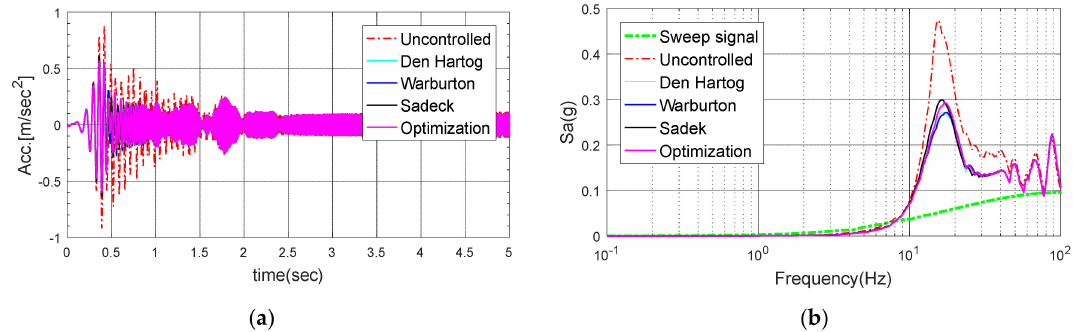
Figure 20. Acceleration response at the top of the electrical cabinet when subjected to a sinusoidal sweep wave: ( a ) Time history; ( b ) Response